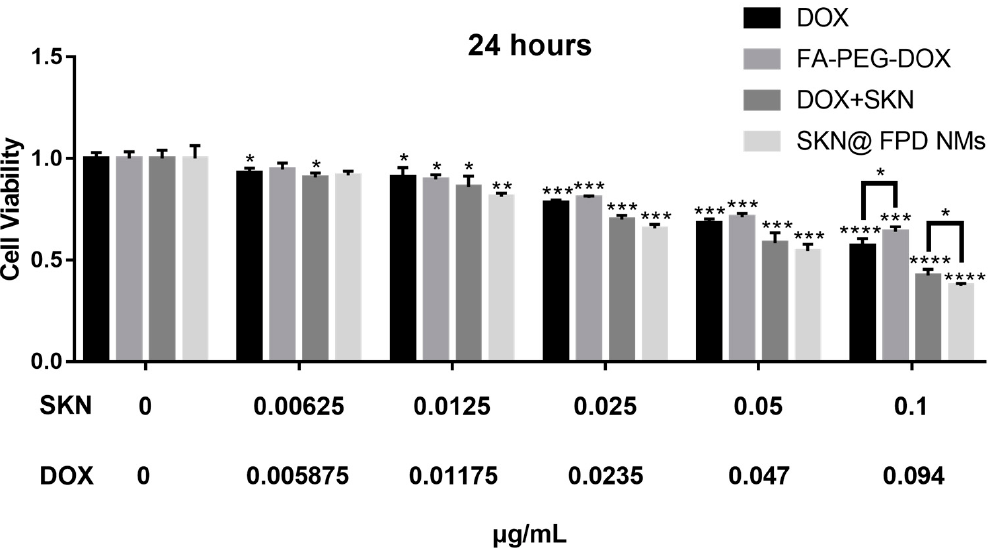
Figure 6. Cell toxicity of DOX, FA-PEG-DOX, free dual drugs, and SKN@FPD NMs in MDA-MB-231 cells. * p < 0.05, ** p < 0.01, *** p < 0.001, and **** p < 0.0001 represent significant differences.